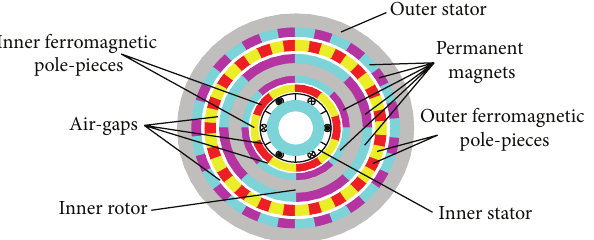
Figure 1: Topology and prototype of the electromechanical inte- grated magnetic